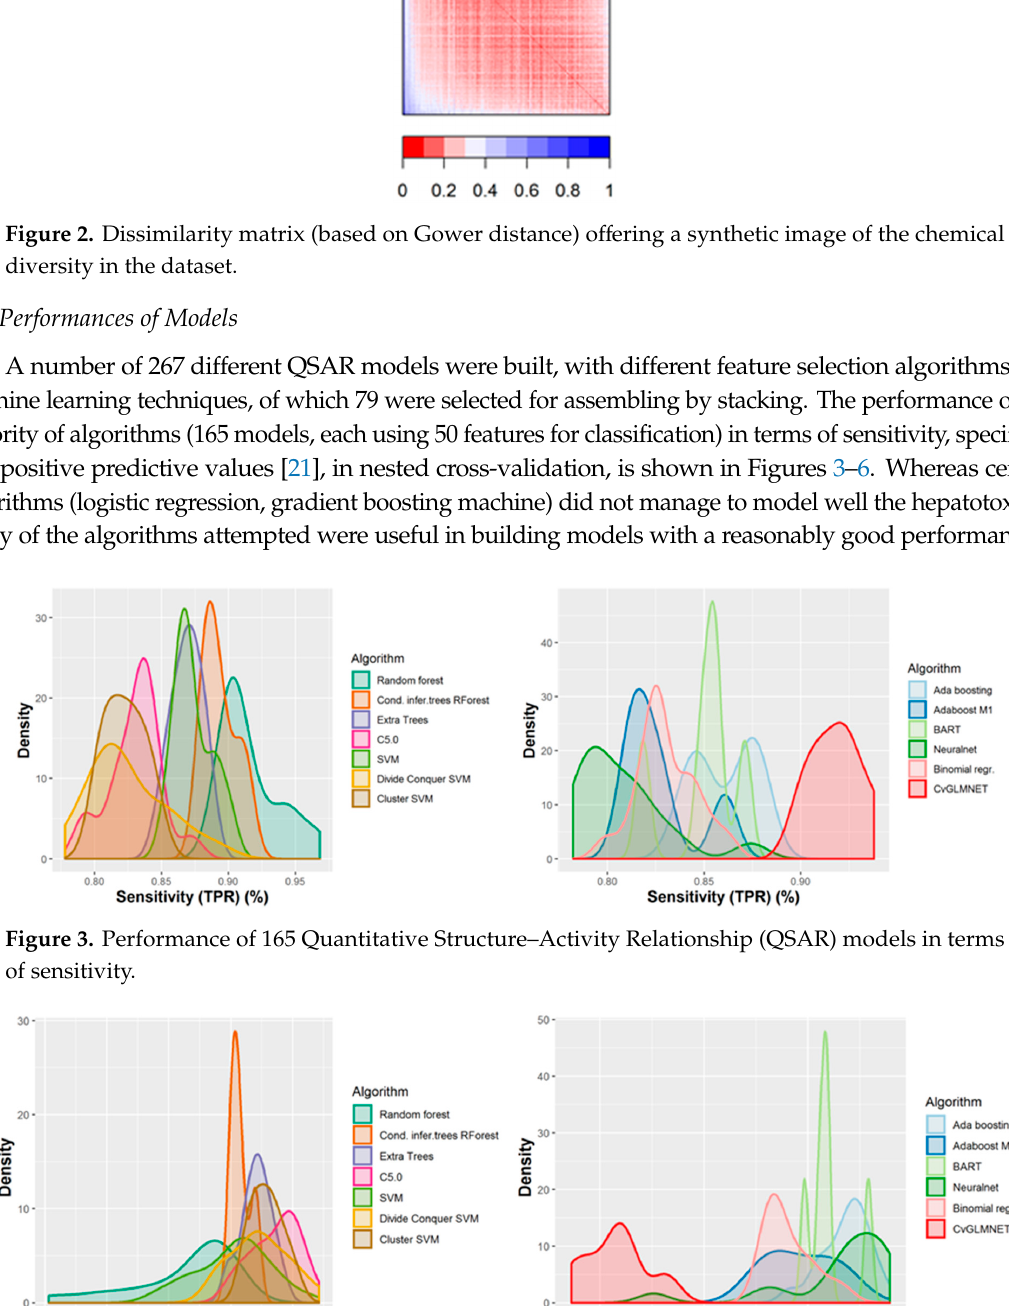
Figure 4. Performance of 165 QSAR models in terms of specificity.